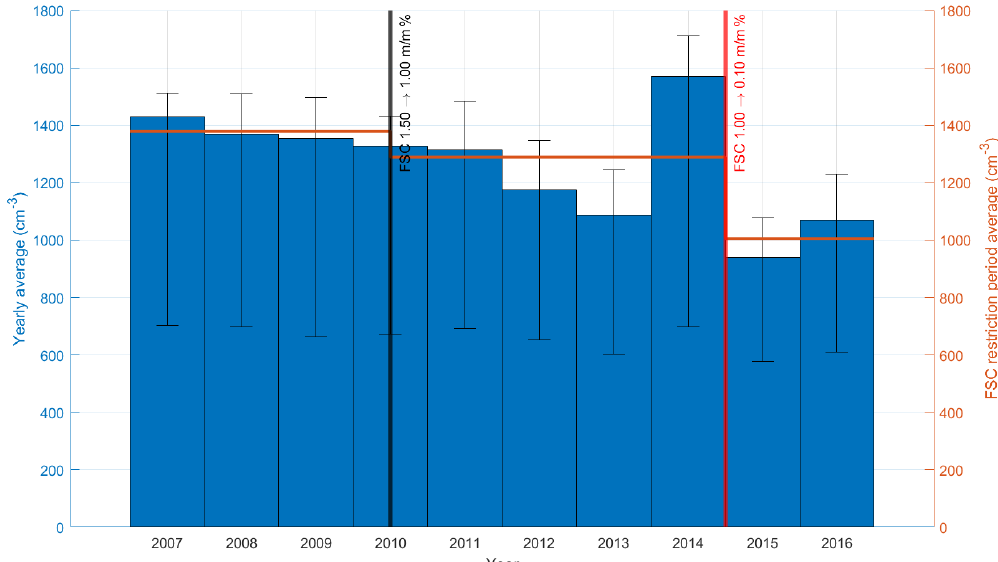
Figure 5. Annual average particle number concentrations of plumes (PNC pl , blue bars), and the average PNC pl during different FSC restric- tion periods (orange lines). Changes in the FSC restrictions are marked with the black and red vertical lines. The 25th and 75th percentiles are marked with the black error bars.